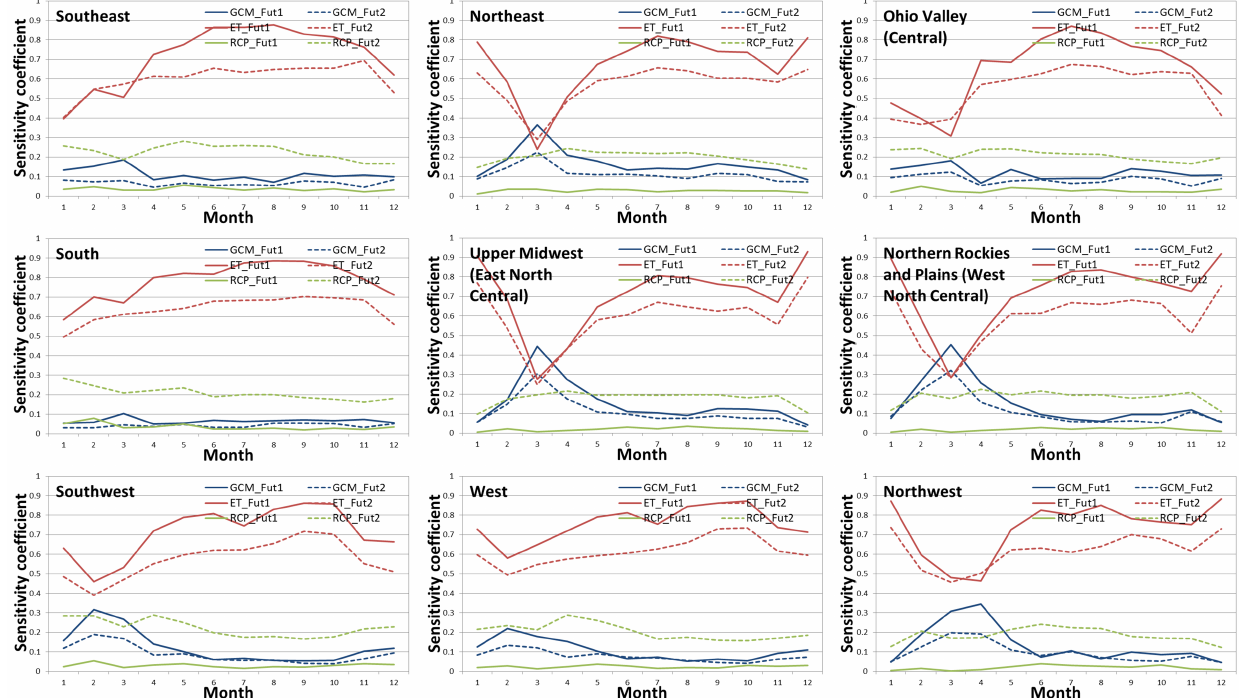
Figure 6. First-order sensitivity analysis results of change in reference evapotranspiration. Solid lines represent future period 1 (2030–2060) and dotted lines represent future period 2 (2070–2100). Blue lines represent the first-order effect of GCMs, red lines represent the first-order effect of ET 0 estimation methods, and green lines represent the first-order effect of